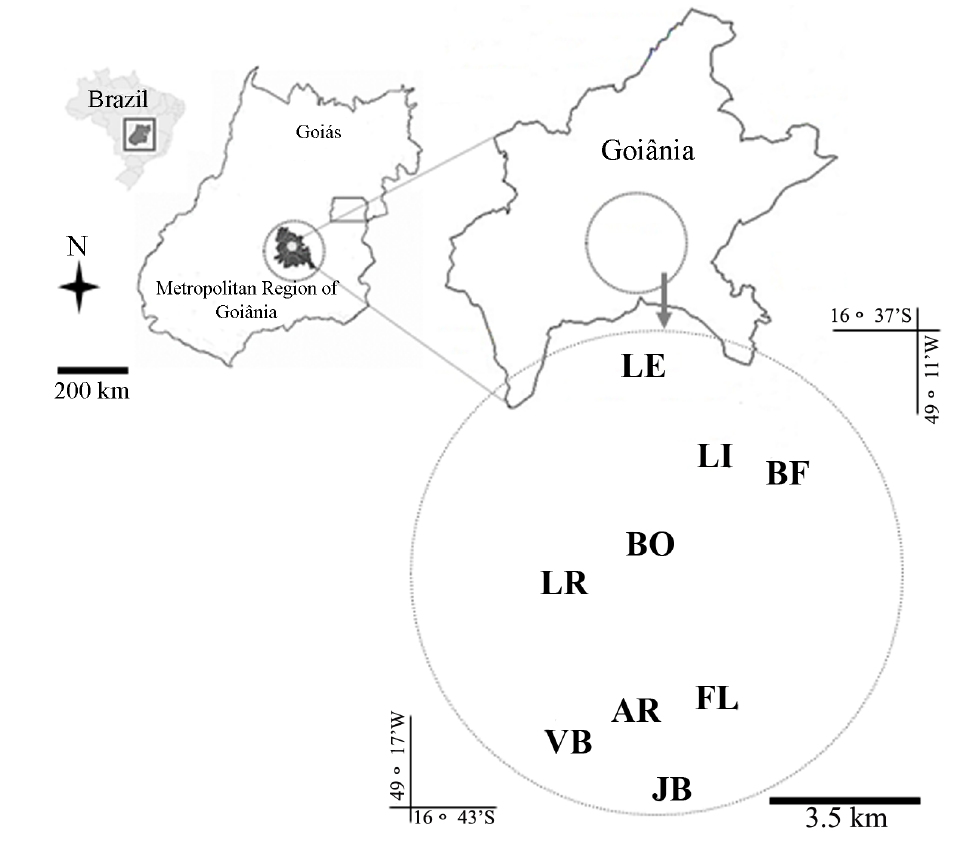
Figure 1. Study area. Codes correspond to the nine ponds (see Table